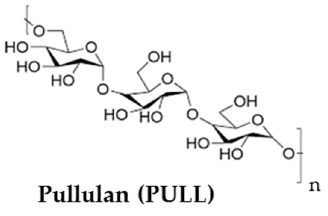
Figure 12. The structure of pullulan.